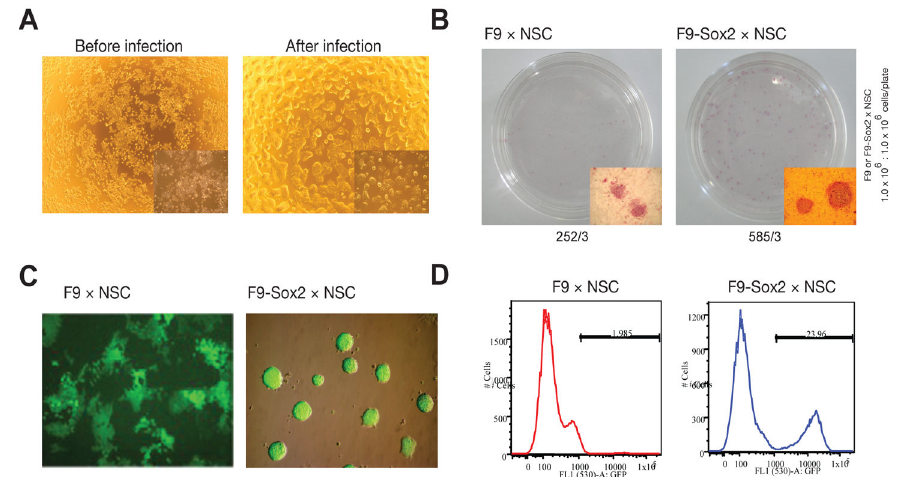
Figure 4. Role of Sox2 on the reprogramming potential of cells from a non-epiblast origin. ( A ) F9 ECCs overexpressing Sox2 exhibited a different morphology and presented more compact and round-shaped colonies. ( B ) The colony-forming rate was determined by AP staining after 1week of neomycin selection. Data is represented as the number of total colonies from 3 different experiments. ( C ) Morphology of both F9 hybrid cells and F9- Sox2 hybrid cells. ( D ) The reprogramming rates of both F9 and F9- Sox2 hybrids were calculated by counting the number of Oct4 -GFP–positive cells via FACS. doi: